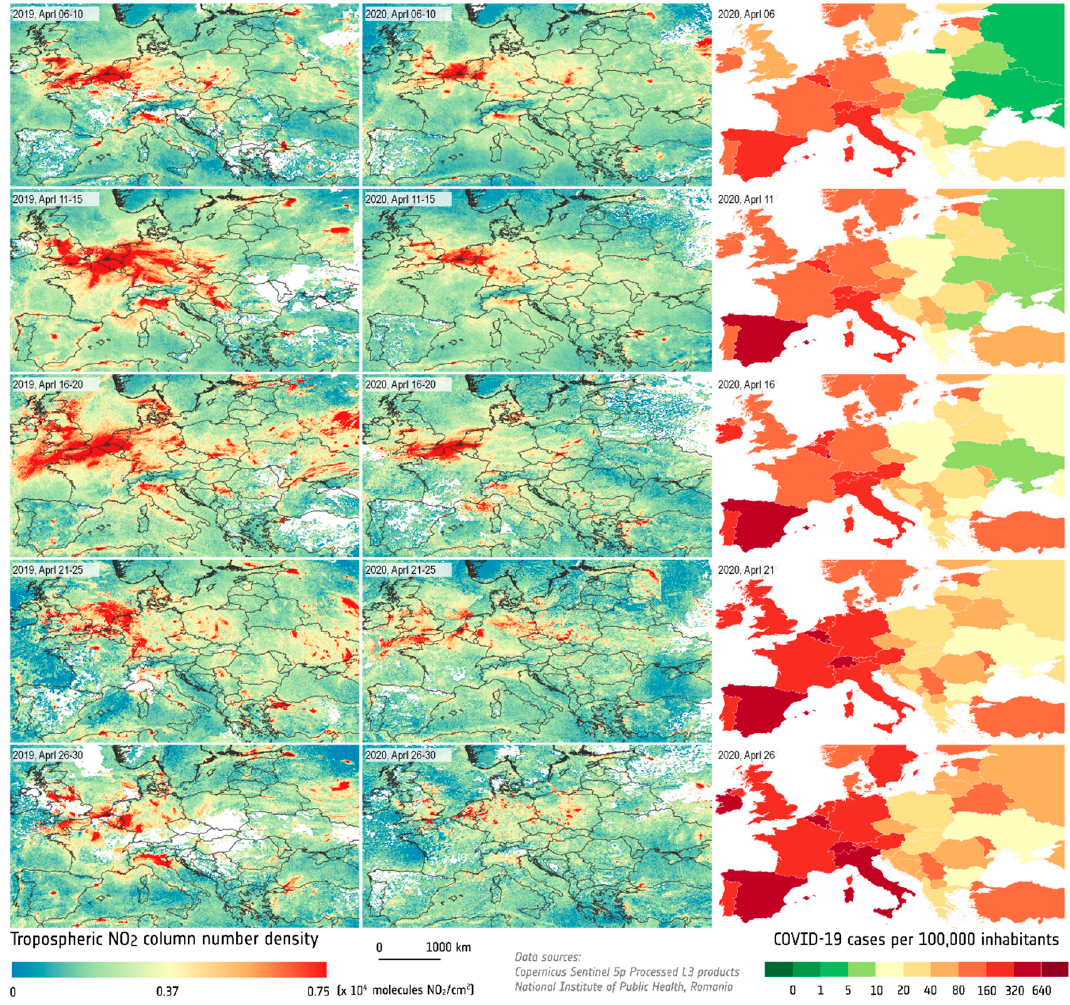
Figure 3. Comparative cartographic representations of the 5-day average tropospheric NO 2 column number density over Europe between 6 and 30 April in 2019 and 2020, and the incidence rate of COVID-19 confirmed cases in European countries.